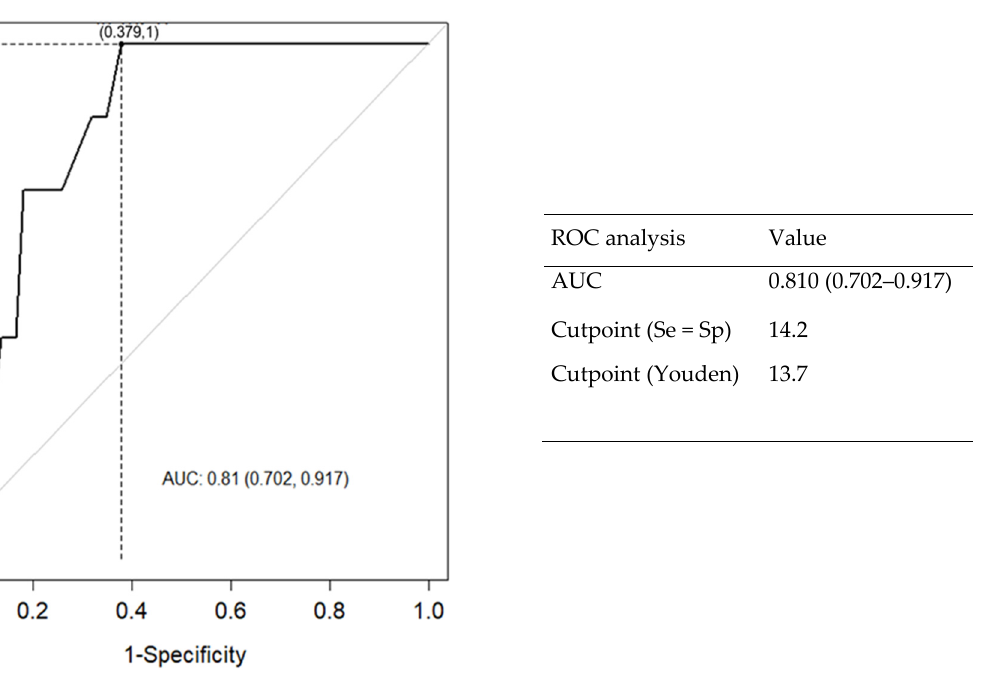
Figure 4. ROC curve to verify the relationship between the degree of atrophy and RDW. Abbreviations RDW, Red cell distribution width: ROC, Receiver operating characteristic. Table 6. Association between RDW with atrophy grade III.